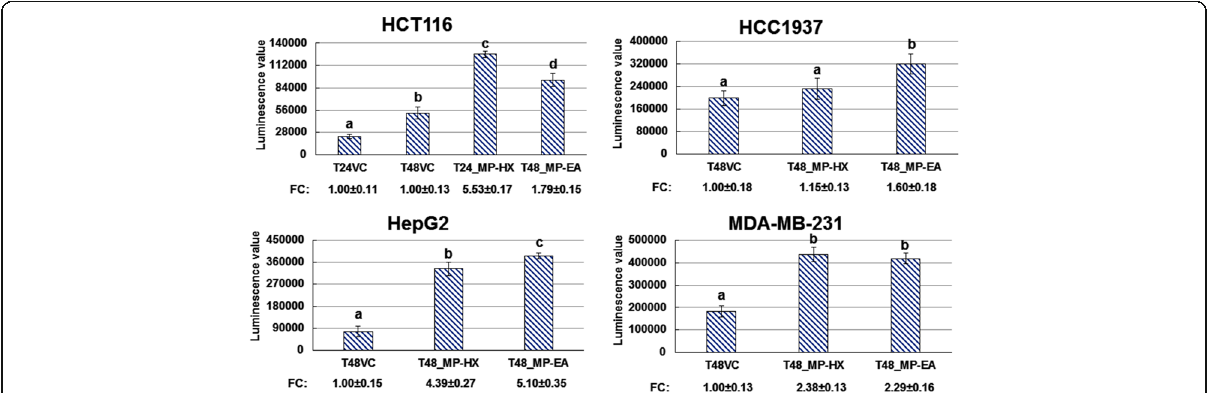
Fig. 5 The effect of MP-HX or MP-EA on caspase 3/7 activity in cancer cell lines. The bar charts depict luminescence value for caspase 3/7 activity. The concentration of the extracts used in each treatment was at ~IC 50 value for the corresponding cell lines indicated. T24/T48, 24 or 48 h treatment, respectively. VC, vehicle control; FC, fold change compared to VC. Values are mean ± SD ( n = 3). The values with different letters (a-d) are significantly different, p <